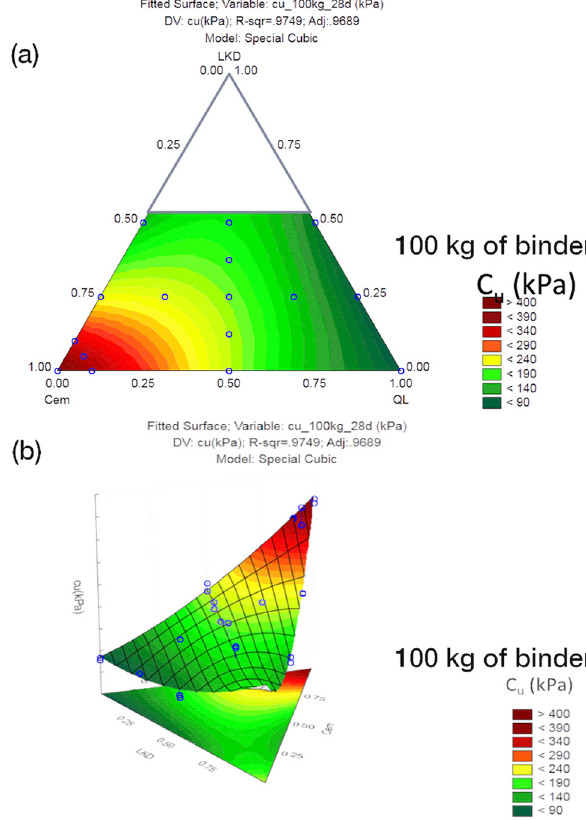
Figure 5: Response surface with internal points showing shear strength after 28 days of curing at 7 °C . The amount of binder 100 kg m 3 / . ( a ) 2D view; ( b ) 3D